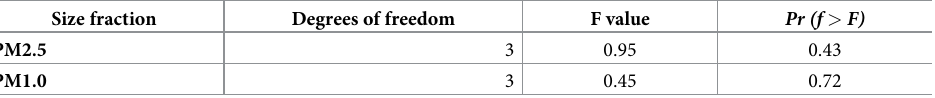
Note: ANOVAs include comparisons of averaged concentrations (over half-days) from each of the four trials (air cleaner on high, fan on; air cleaner on low, fan on; air cleaner on high, fan off; air cleaner on low, fan on) in two